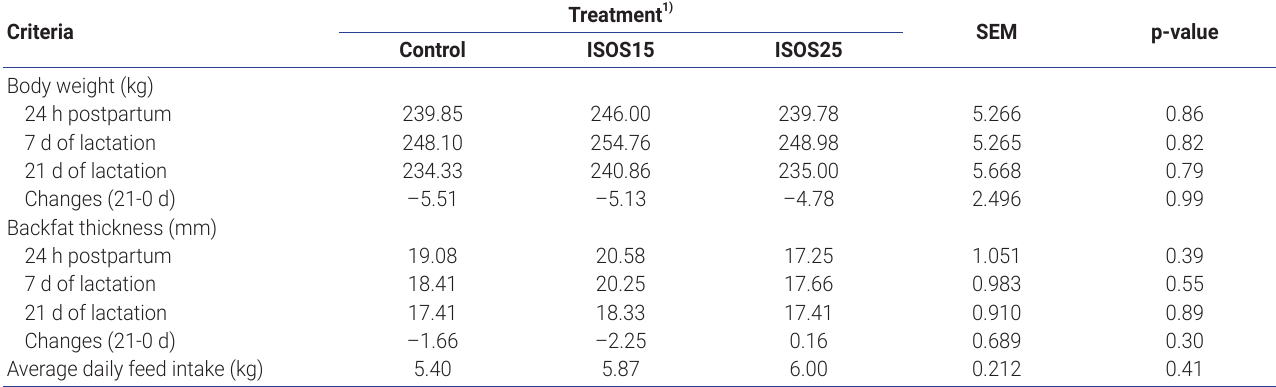
Table 2. Effects of supplemental selenium in the lactation diet on the body weight and backfat thickness of sows during lactation